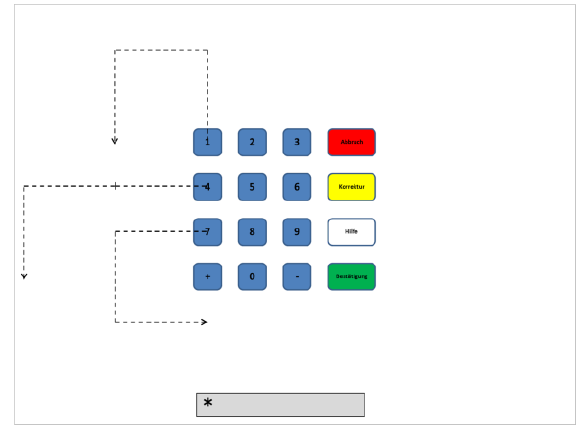
Figure 1. PIN interface with exemplary button movements (dashed lines).